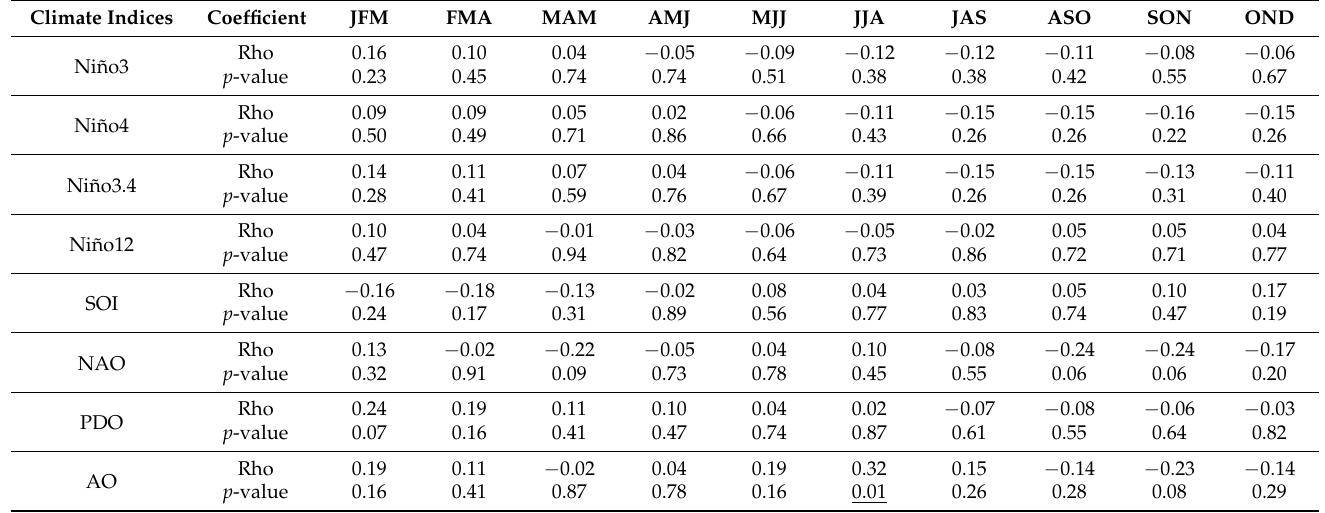
Table 1. Spearman rank correlation results between climate indices and AMFP ( α =